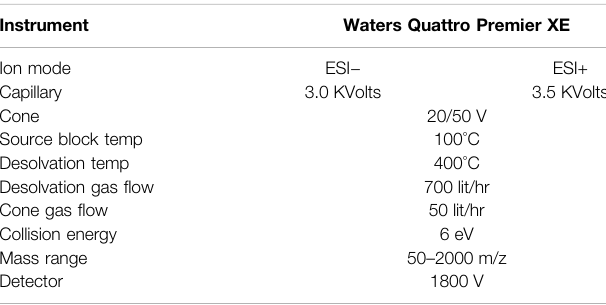
TABLE 2 | Detection conditions of LC-MS.